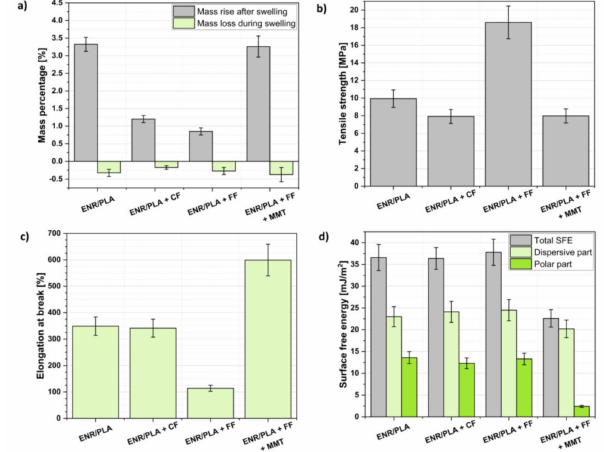
Figure 2. ENR/PLA blend properties before the accelerated aging processes: ( a ) analysis of the swelling experiment, ( b ) tensile strength of analyzed specimens, ( c ) elongation at break of investigated samples, ( d ) surface free energy, and its components